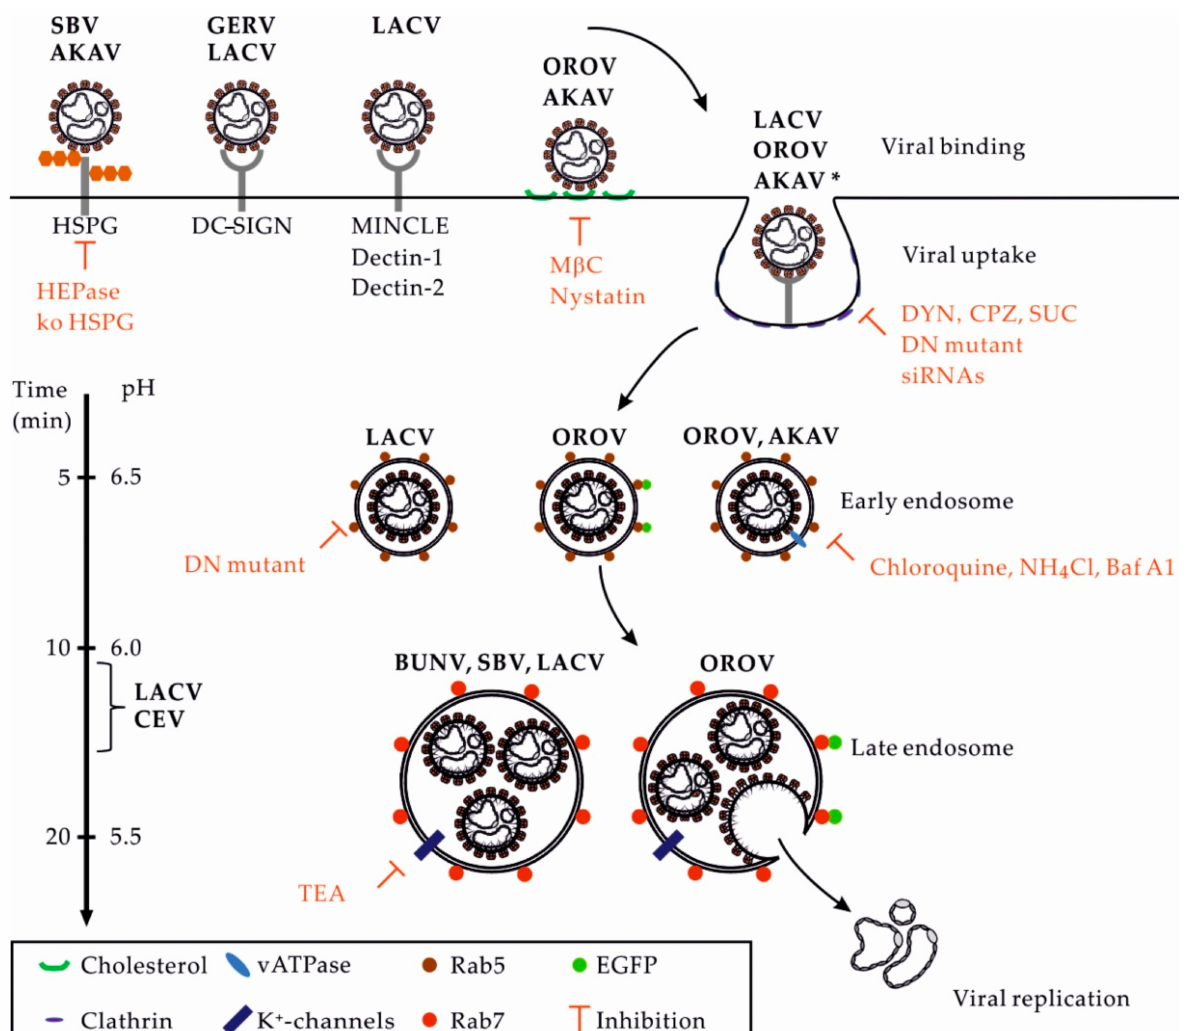
Figure 3. OBV entry into mammalian cells. This figure provides an overview of the entry pathways used by some OBVs to infect host cells. On the left, the scales indicate the time for the trafficking of cargo from the surface to an organelle and the related pH inside endosomal vesicles. Abbreviations: AKAV, Akabane virus; Baf A1, bafilomycin A1; BUNV: Bunyamwera virus; CEV, California encephalitis virus; CME, clathrin-mediated endocytosis; CPZ, chloropromazine; DN, dominant negative; DYN, dynasore; EGFP, enhanced green fluorescent protein; GERV, Germiston virus; HEPase, heparinase; HSPG, heparan sulfate proteoglycan; LACV, La Crosse virus; M β C, methyl- β -cyclodextrin; NH 4 Cl, ammonium chloride. OROV, Oropouche virus; SBV, Schmallenberg virus; SUC, sucrose; TEA, tetraethylammonium; * Other viruses using the CME pathway, including the CEV and Inkoo, Jamestown canyon, Keystone, Melao, Serra do Navio, snowshoe hare, Tahnya, and Trivittatus